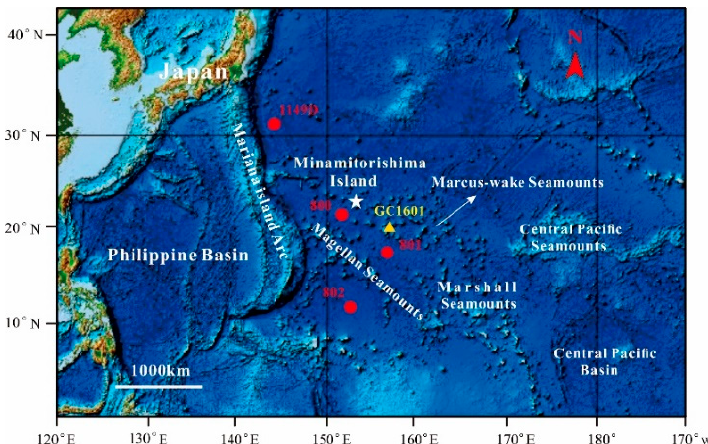
Figure 1. Geography and location of GC1601 from Northwest Pacific. The red dots represent the geographic locations of Ocean Drilling Program (ODP) sites.